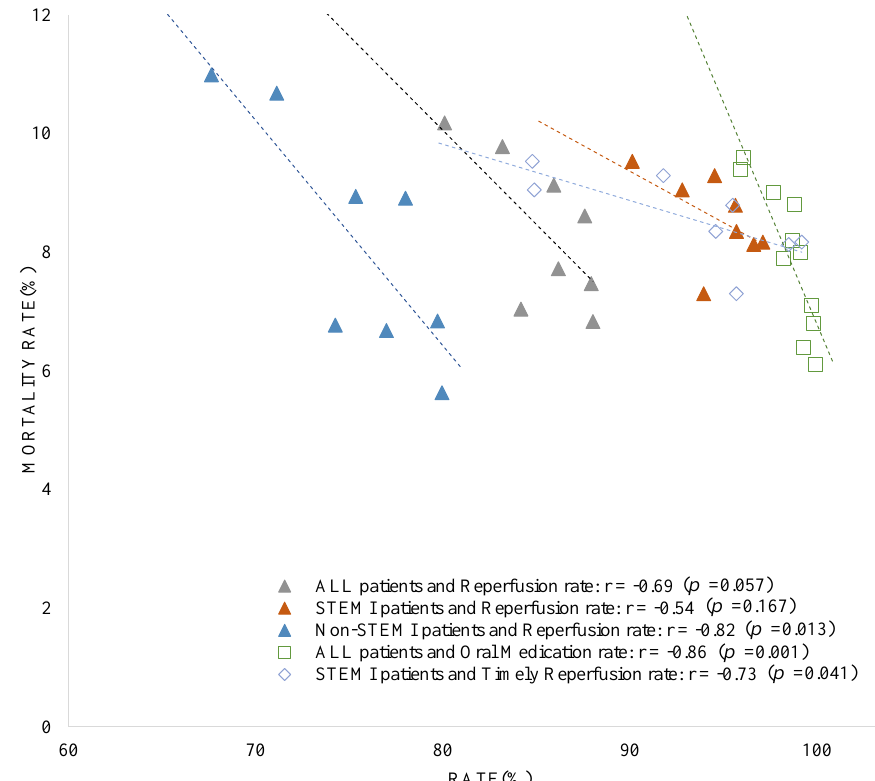
ALL patients and Reperfusion rate: r = -0.69 STEMI patients and Reperfusion rate: r = -0.54 Non-STEMI patients and Reperfusion rate: r = -0.82 ALL patients and Oral Medication rate: r = -0.86 STEMI patients and Timely Reperfusion rate: r = -0.73